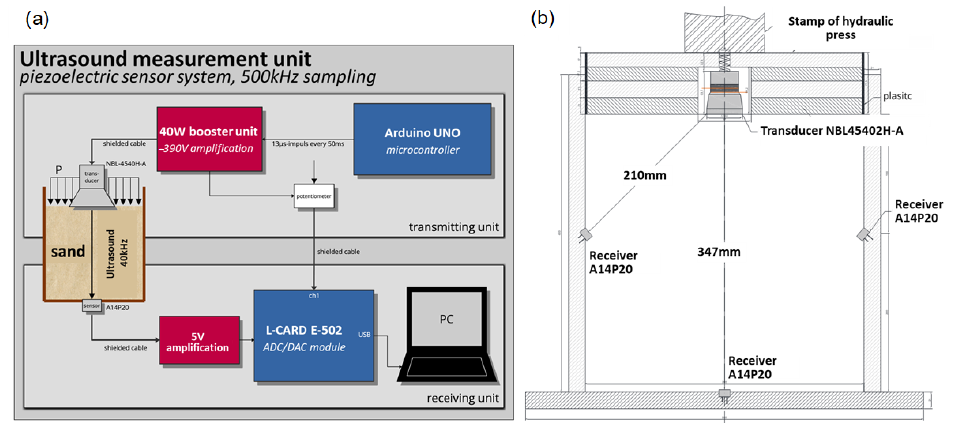
Figure 1. ( a ) Schema of the ultrasound measuring system, ( b ) Drawing of the test box with ultrasonic transmitter and receivers.